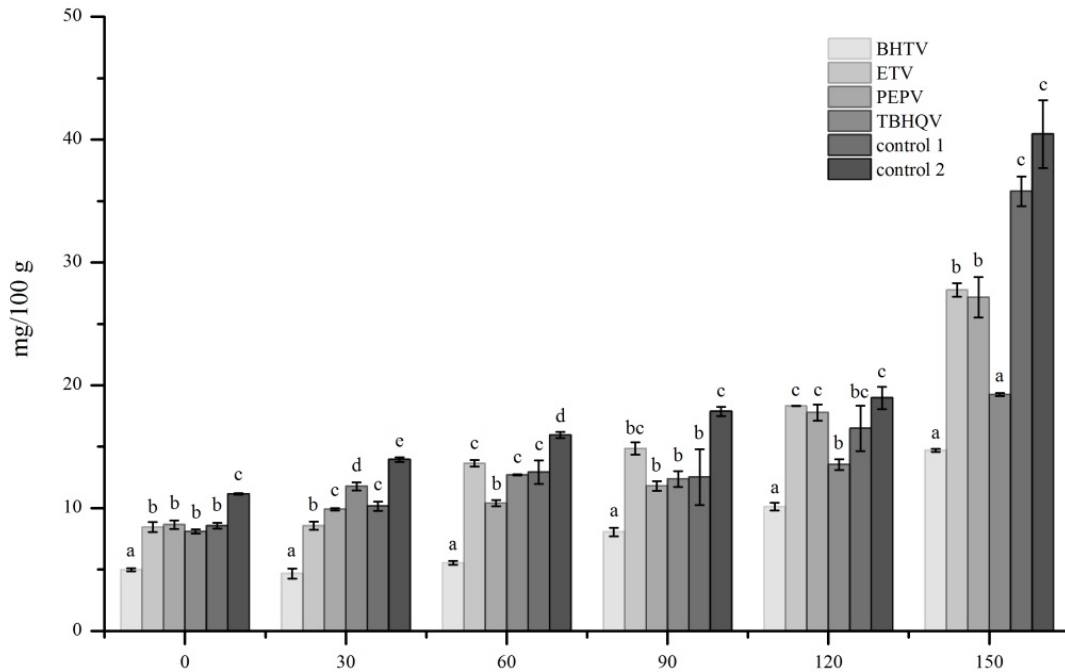
Figure 1. Changes in peroxide values (PVs) of deep fried Gryllus bimaculatus . BHTV = Figure 1 . Changes in peroxide values (PVs) of deep fried Gryllus bimaculatus . BHTV = 0.2% BHT + vacuum-filling nitrogen packaging; ETV = 0.5% ET + vacuum-filling nitrogen packaging; PEPV = 0.5% PEP + vacuum-filling nitrogen packaging; TBHQV = 0.2% TBHQ + vacuum-filling nitrogen